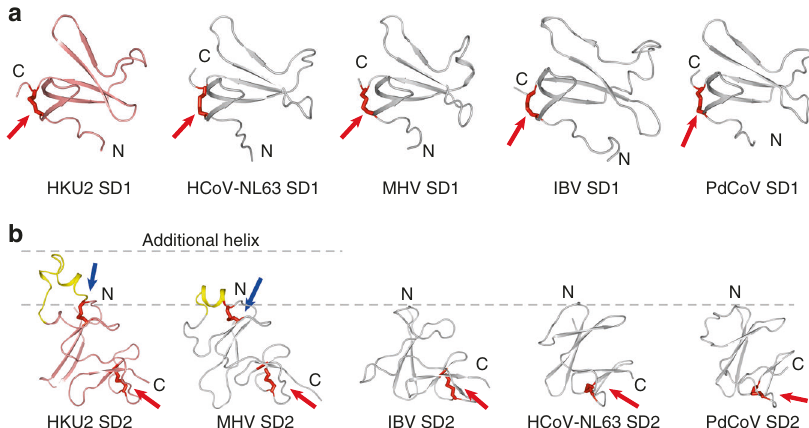
Fig. 4 Structures of SD1 and SD2 and comparisons. a Comparison of SD1 from four genera of coronaviruses. HKU2 SD1 is colored salmon; SD1 from other coronaviruses are colored gray. Disul fi de bonds are shown as red sticks. Red arrows indicate the disul fi de bonds conserved in all genera of coronaviruses. PDB codes: HCoV-NL63, 5SZS; MHV, 3JCL; IBV, 6CV0; PdCoV, 6B7N. b Comparison of SD2 from four genera of coronaviruses. HKU2 SD2 is colored salmon; SD2 from other coronaviruses are colored gray. Disul fi de bonds are shown as red sticks. Red arrows indicate the disul fi de bonds conserved in all genera of coronaviruses. Blue arrows indicate the disul fi de bonds only found in HKU2 (and SADS-CoV) and β -CoVs. The additional helices of SD2 from HKU2 (and SADS-CoV) and β CoVs are colored yellow and partitioned by gray dashed lines. PDB codes: HCoV-NL63, 5SZS; MHV, 3JCL; IBV, 6CV0; PdCoV, 6B7N.